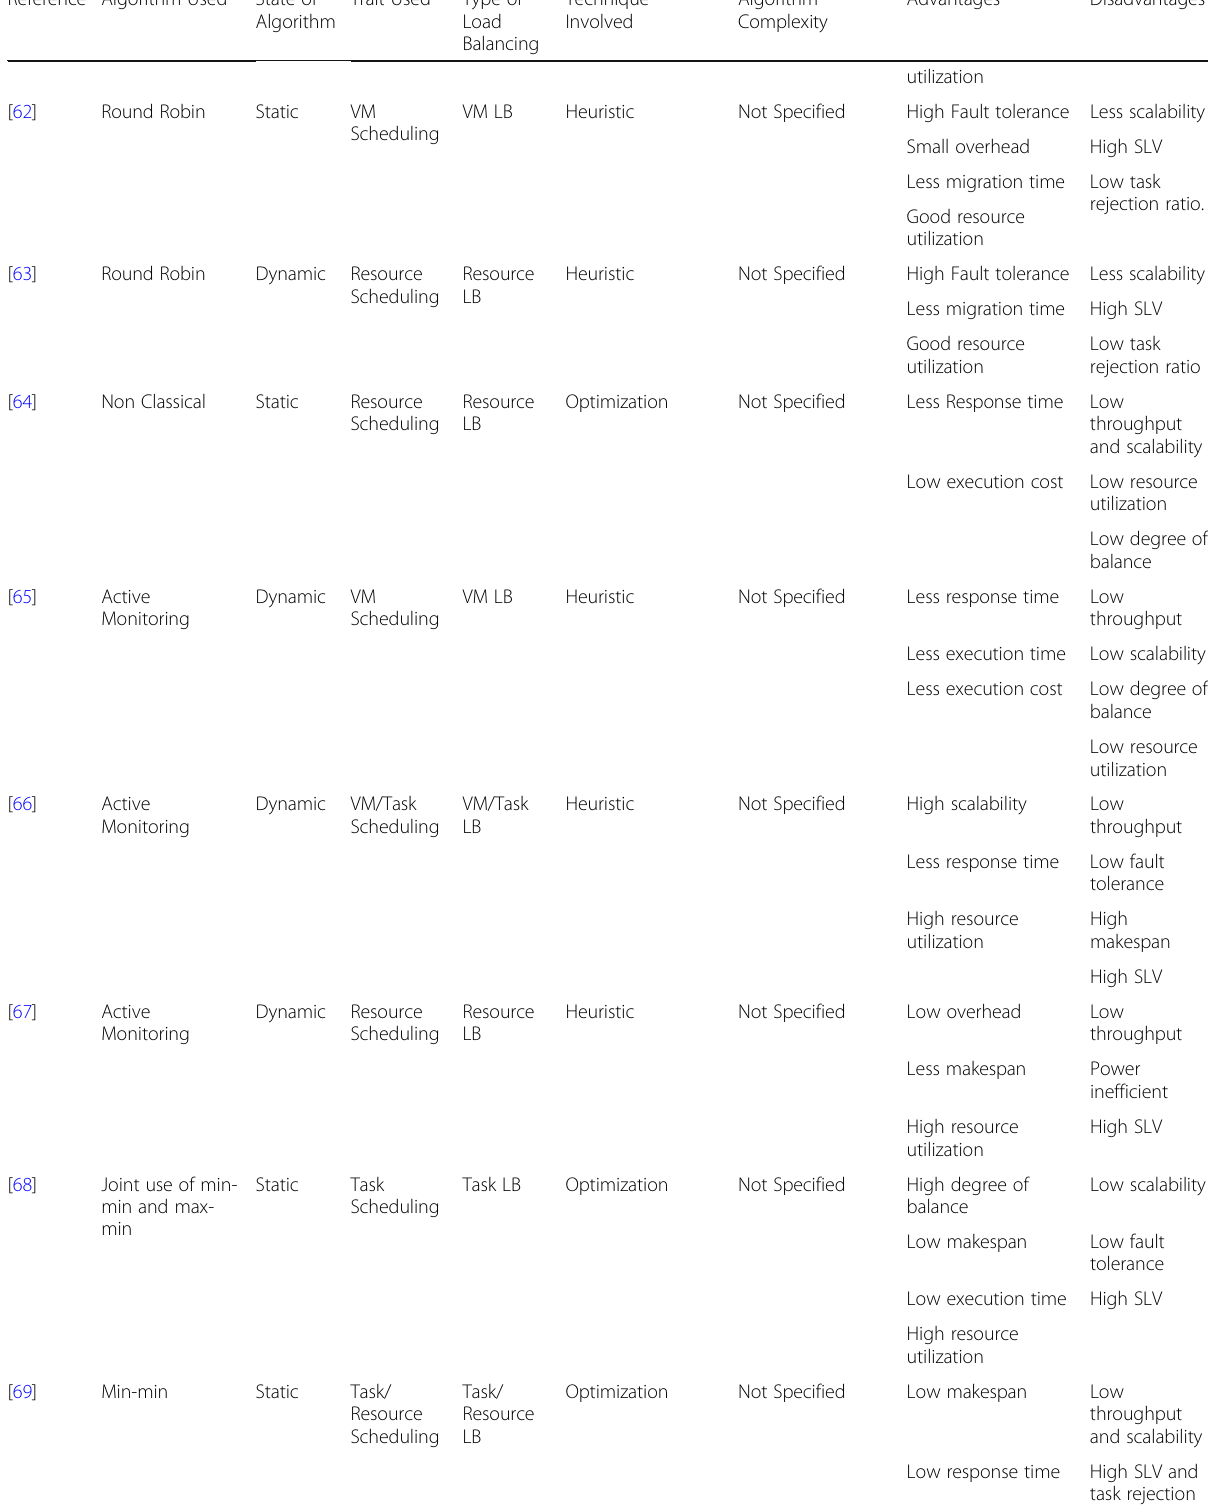
Table 2 Reactive approaches of cloud load balancing in existing literature (Continued) Reference Algorithm